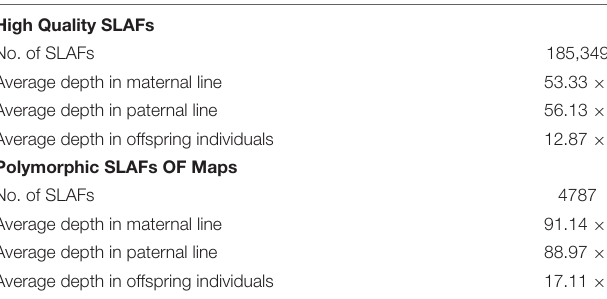
TABLE 2 | Sequencing depth of SLAFs in the genetic map.